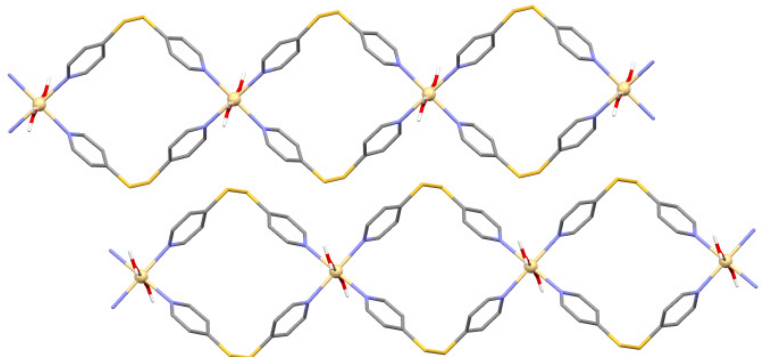
Figure 8. ( a ) Compact arrangement of two adjacent repeated rhomboid strands and ( b ) corrugated layers viewed along the direction of propagation of the strands in O) ( μ - dtdp ) }(NO ) ·2CH OH·2H O] (SOMHOS) with nitrate ions and solvent [{Cd(H 2 2 2 3 2 3 2 n molecules sandwiched in